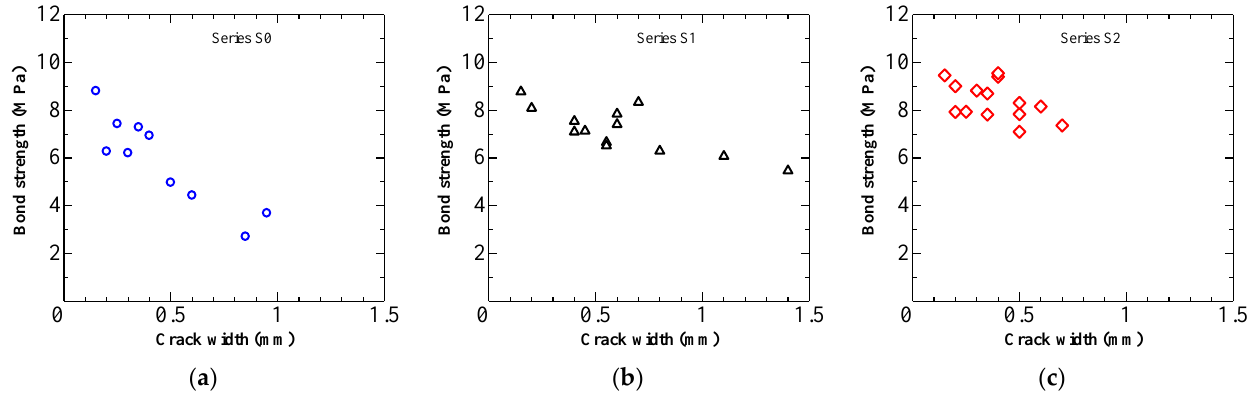
Figure 11. Examples of bond stress versus slippage curves.